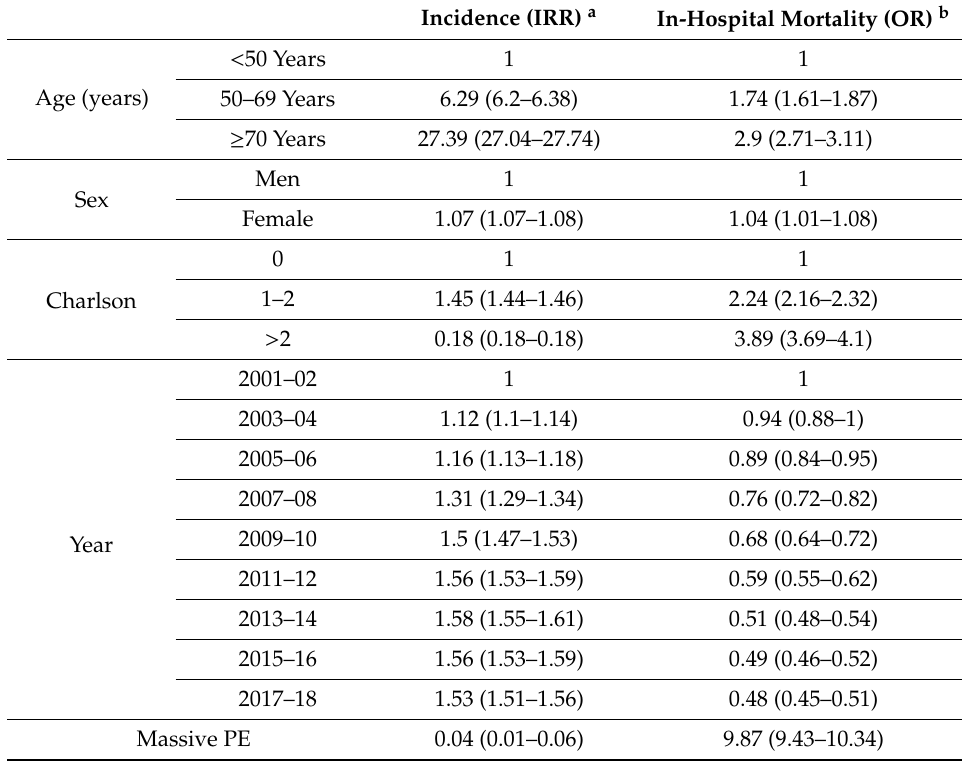
Table 4. Multivariate analysis for incidence and in-hospital mortality for patients hospitalized with pulmonary embolism (PE) in Spain from 2001 to 2018. Incidence (IRR) a In-Hospital Mortality (OR)